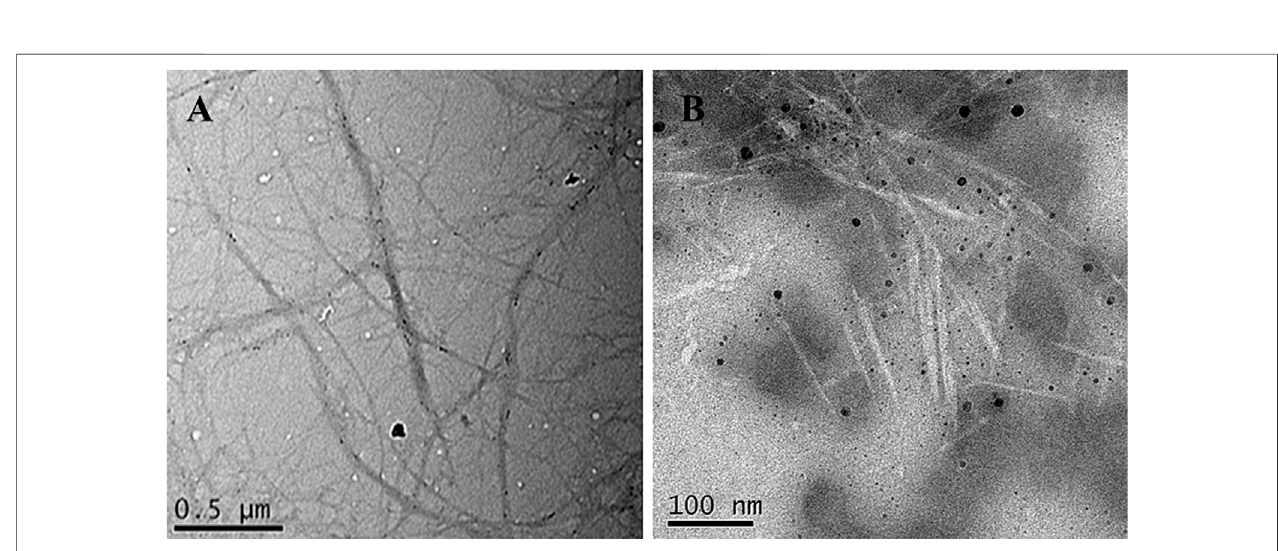
FIGURE 1 | Photographs of IDF, NFC, and CNC powders and their aqueous suspensions after setting aside at room temperature for 24 h.